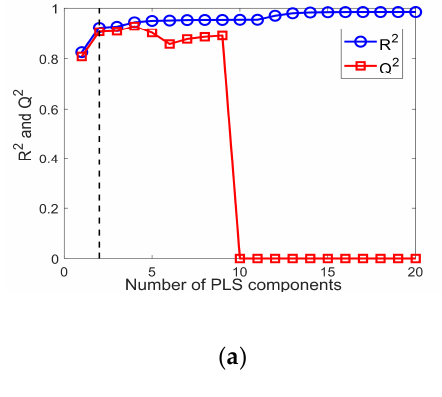
Figure 12. ( a ) R2 and Q2 versus the number of partial least squares (PLS) components for the PLS model of loose bulk density; ( b ) Predicted loose bulk density versus actual loose bulk density of IWMP samples.